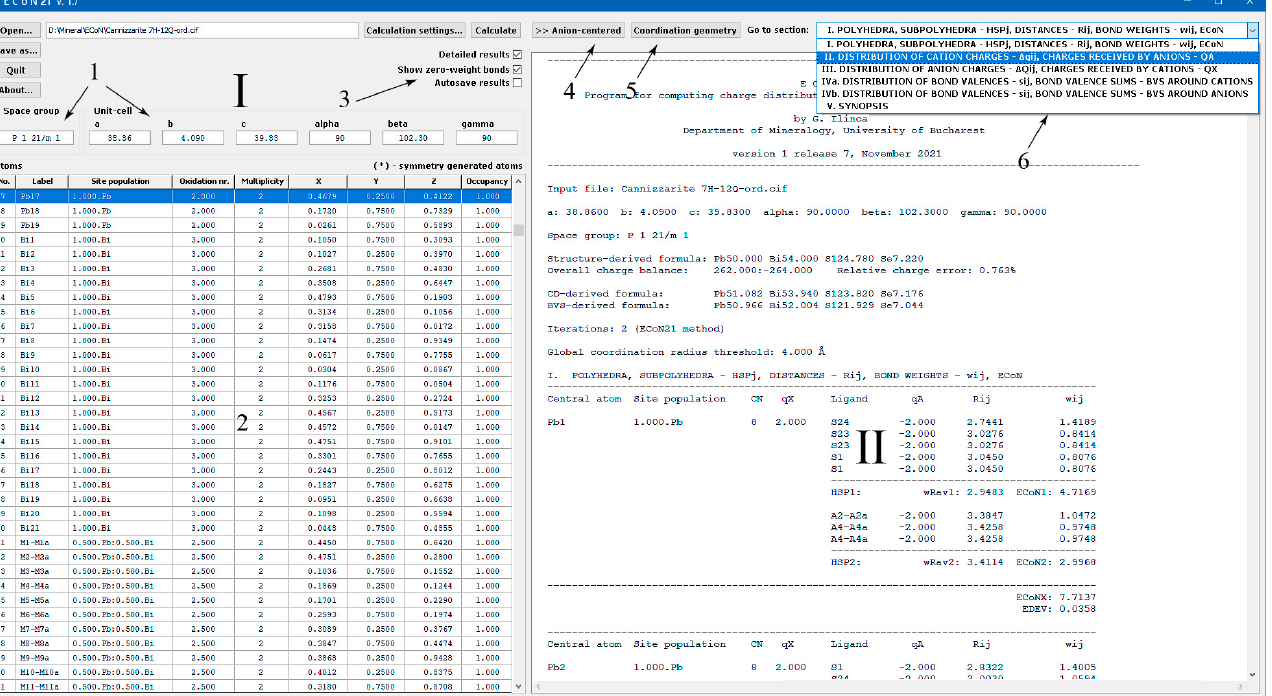
Figure 3. The interface of the ECoN21 program: (I) input panel; (II) results panel; (1) space group and unit–cell parameters panels; (2) atoms table; (3) visualization and save options; (4) switch to anion-centered view; (5) button for visualization of coordination geometry; (6) navigation aid for long outputs.